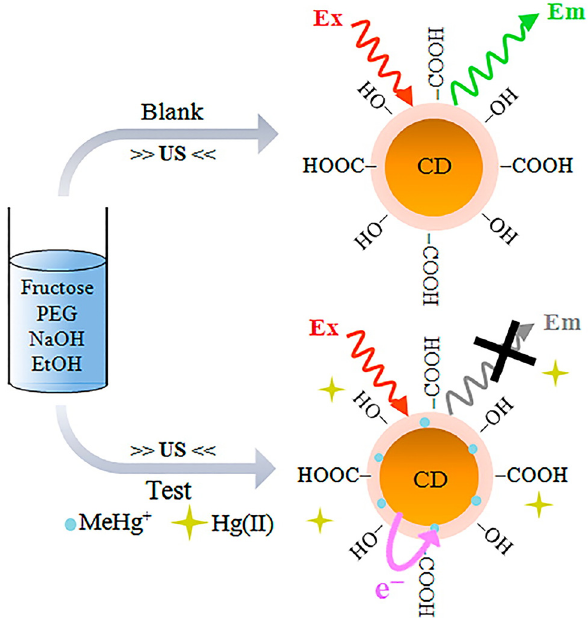
Figure 5: Schematic mechanism of selective speciation of MeHg(I) in presence of Hg(II). Reprinted from Bendicho et al. ’ s work with the kind permission of the American Chemical Society [118]. Copyright (2014) American Chemical Society.